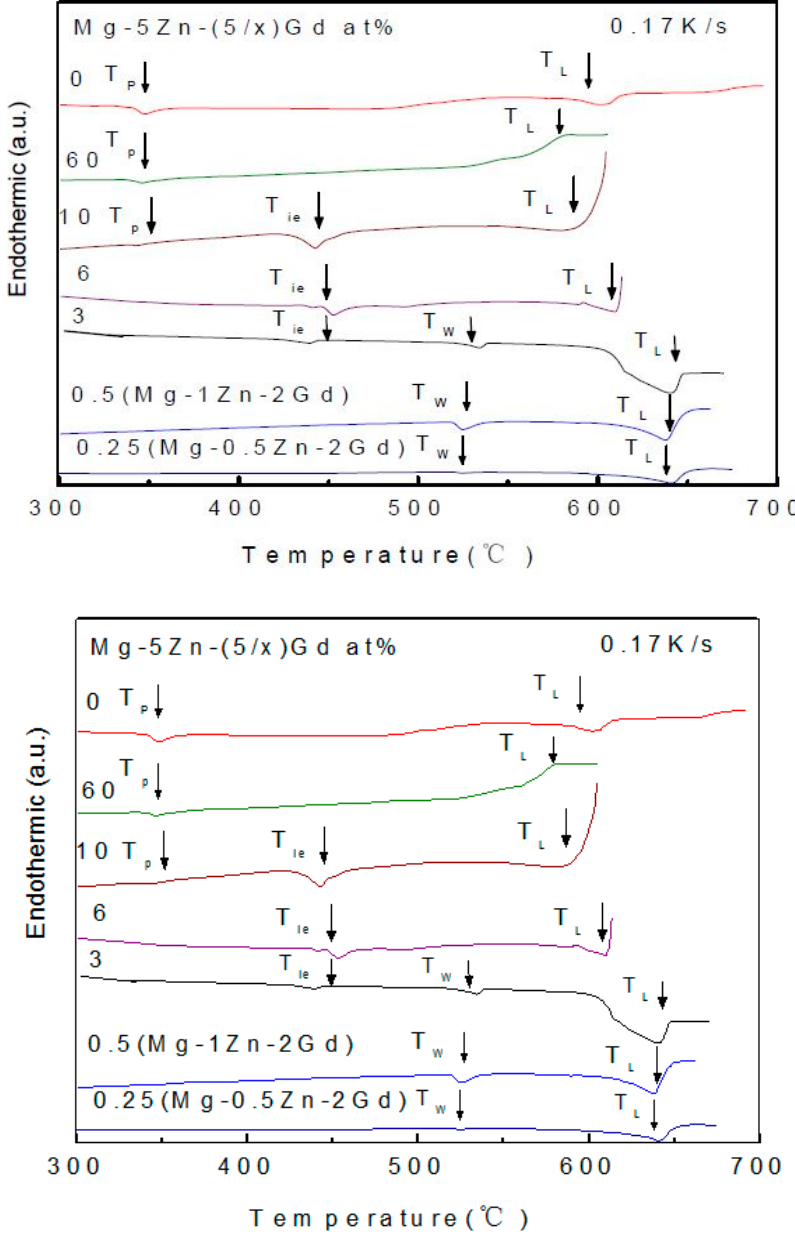
Figure 12. DTA heat trace of Mg-Zn-Gd alloys with 5 at.% Zn (Zn/Gd ratio range from 0.25 to 60, Sample 45, 35, 5, 6, 7, 14, 15).